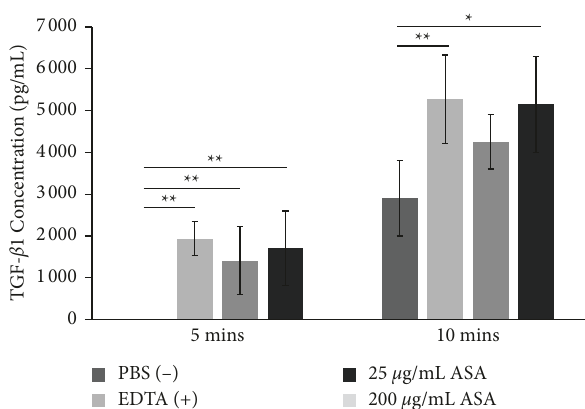
Figure 5: Transforming growth factor β 1 (TGF- β 1) concentration in the supernatant following 5min and 10min of dentin slice conditioning with phosphate-buffered saline (PBS; negative control), ethylenediaminetetraacetic acid (EDTA; positive control), or concentrations of acetylsalicylic acid (ASA) showed that ASA enhanced TGF- β 1 release from dentin in a dose-dependent manner. n 0 .